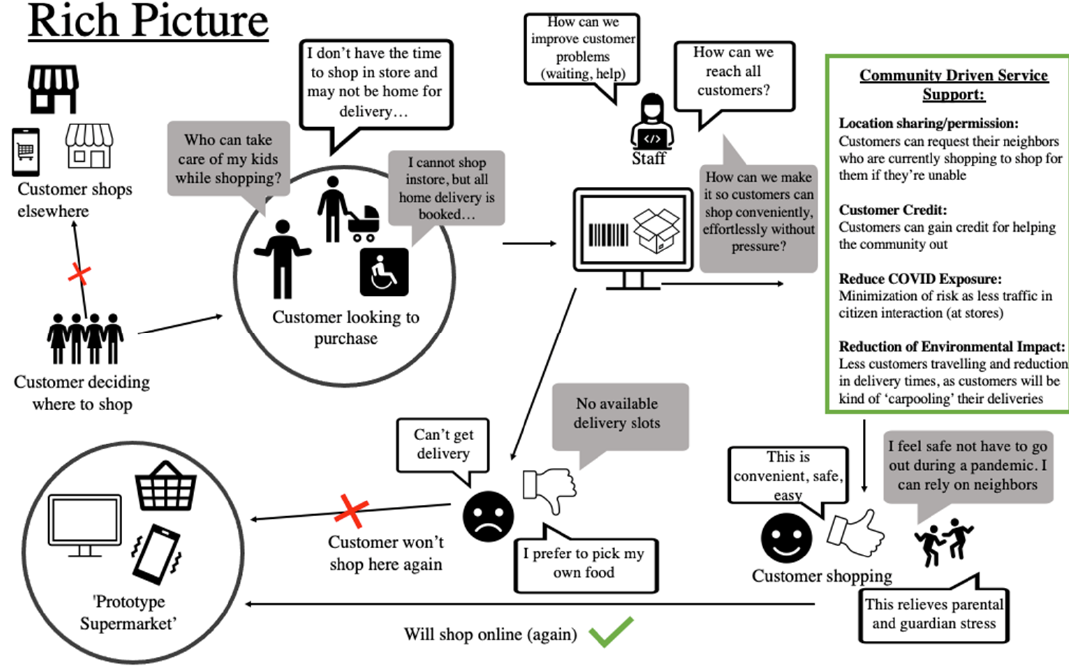
Figure 5. A rich picture of the prototype supermarket.